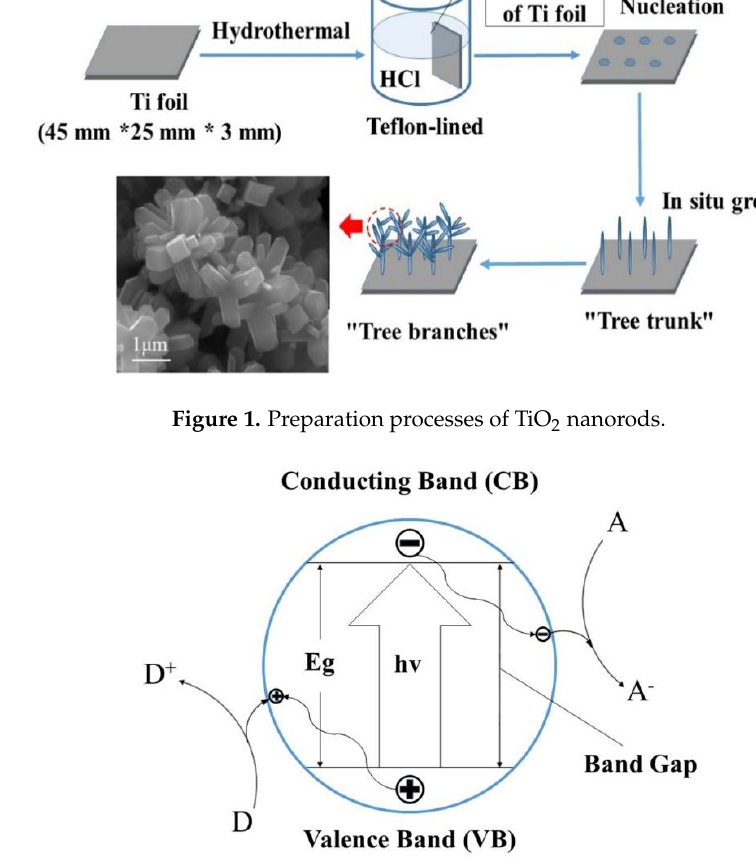
Figure 2. Photocatalytic mechanism of TiO 2 nanorods.